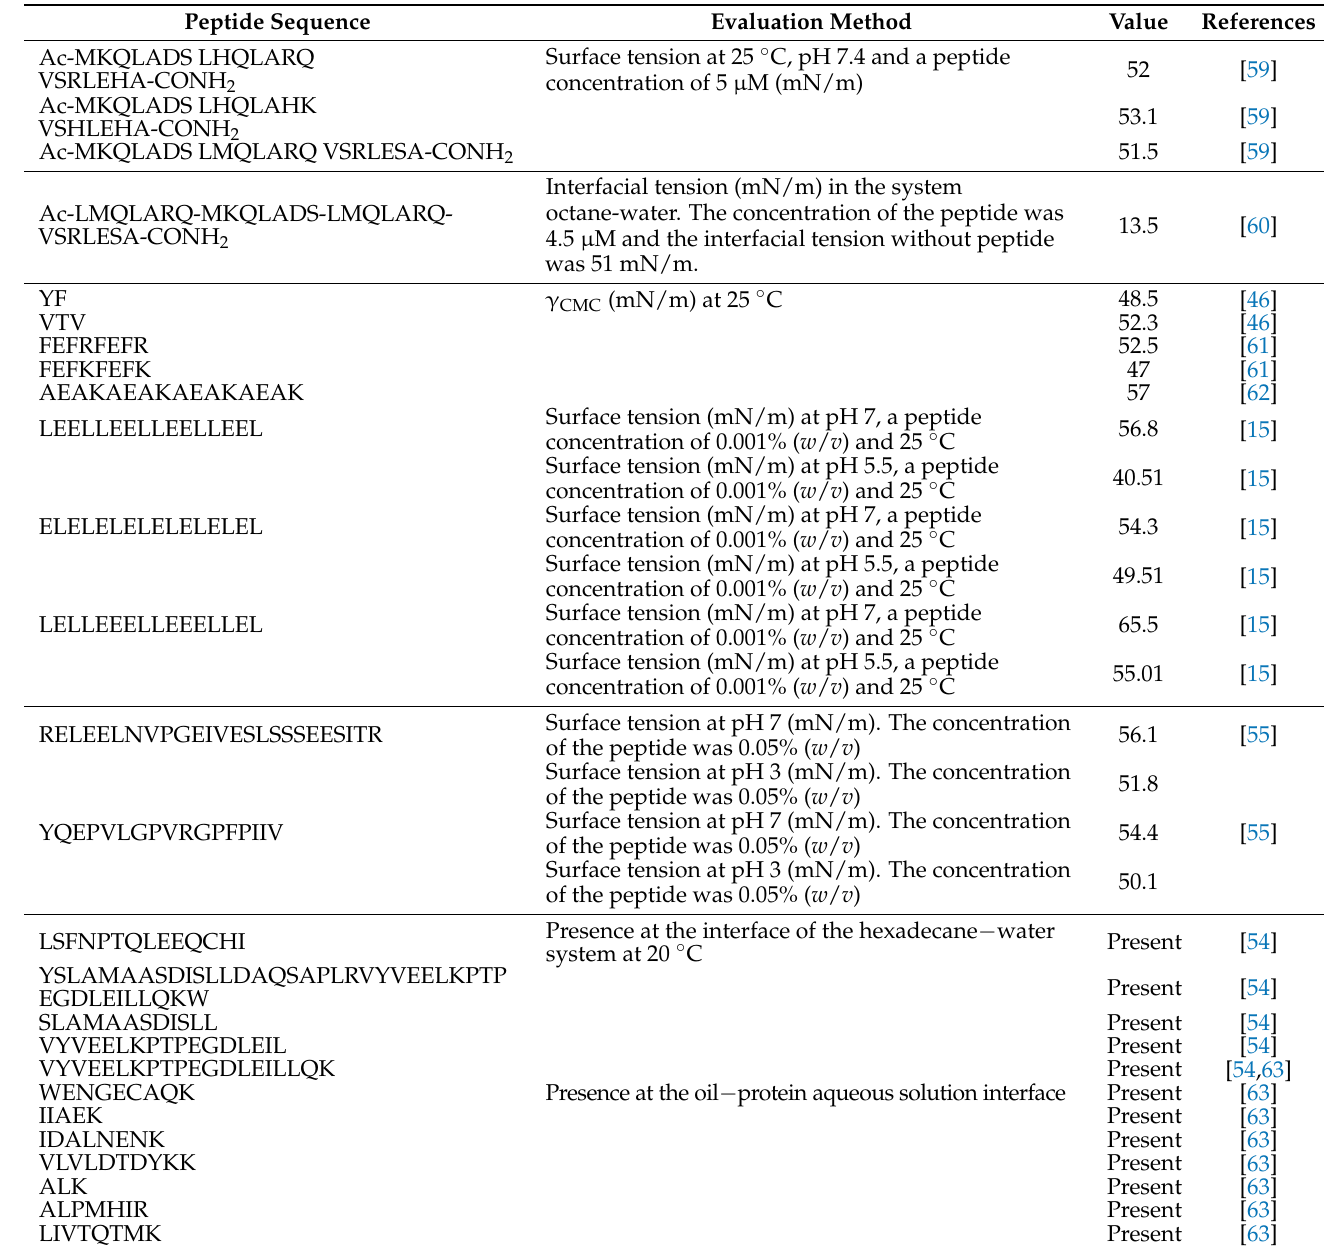
Table 1. Properties of interfacial active